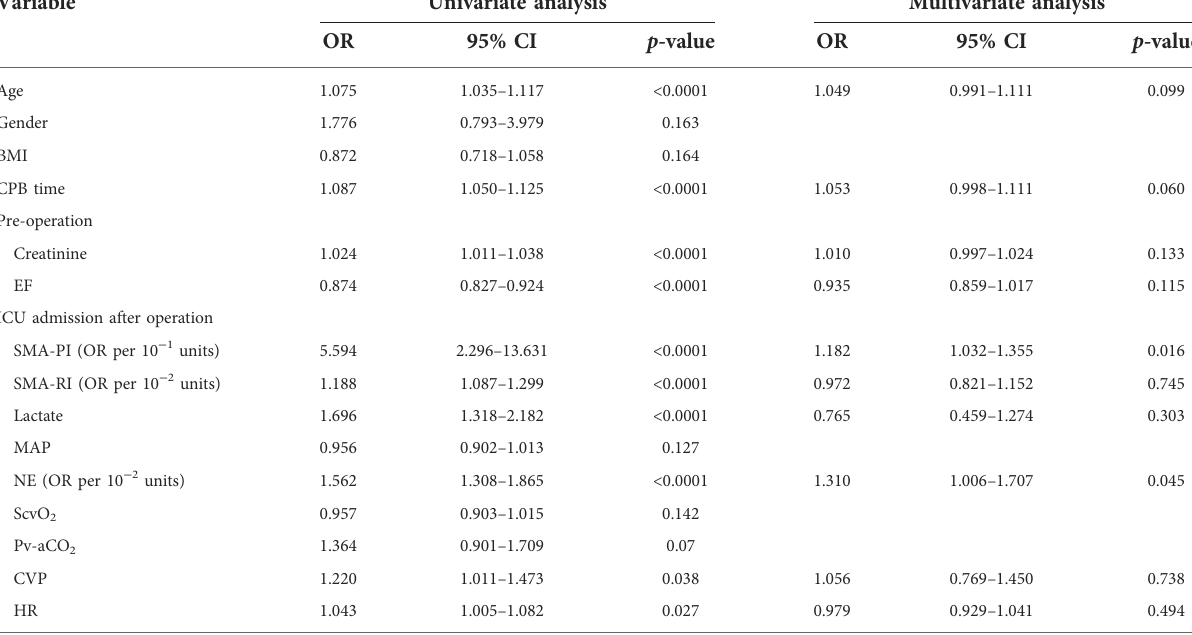
TABLE 3 Logistic regression for baseline characteristics and variables at admission to predict prolonged mechanical ventilation.